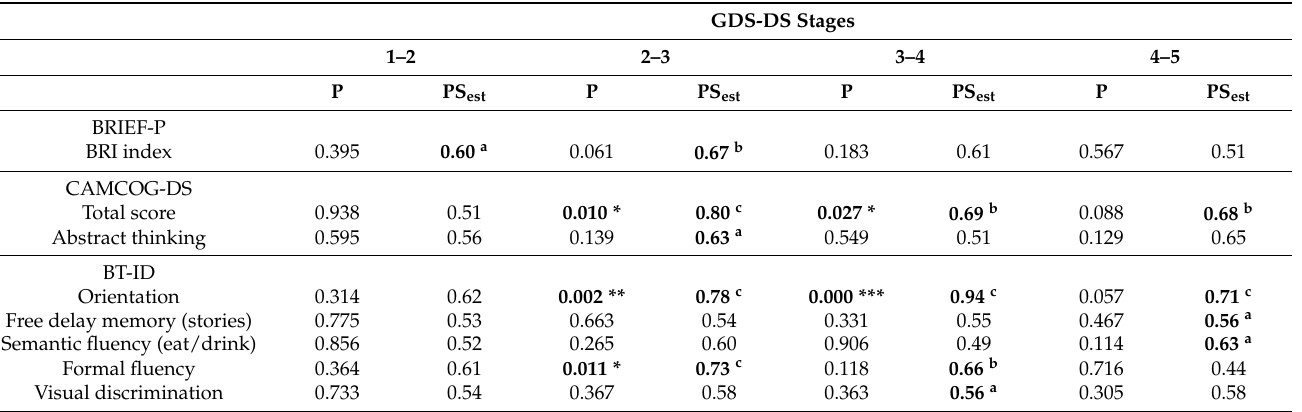
Table 8. Effect sizes between the GDS-DS